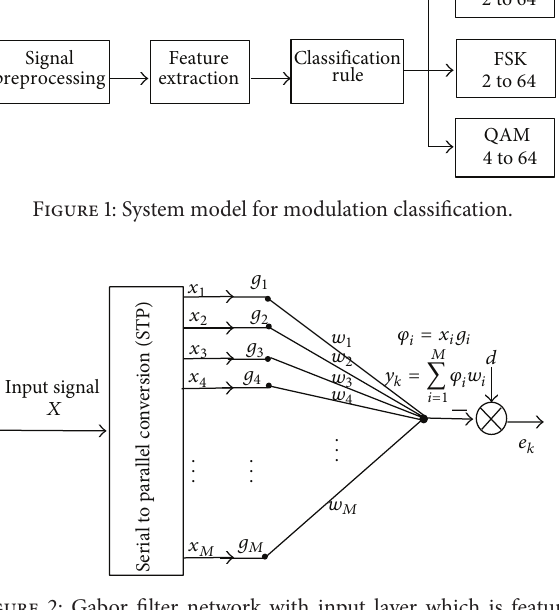
Figure 2: Gabor filter network with input layer which is feature extraction part; weights and output layer are linear classification